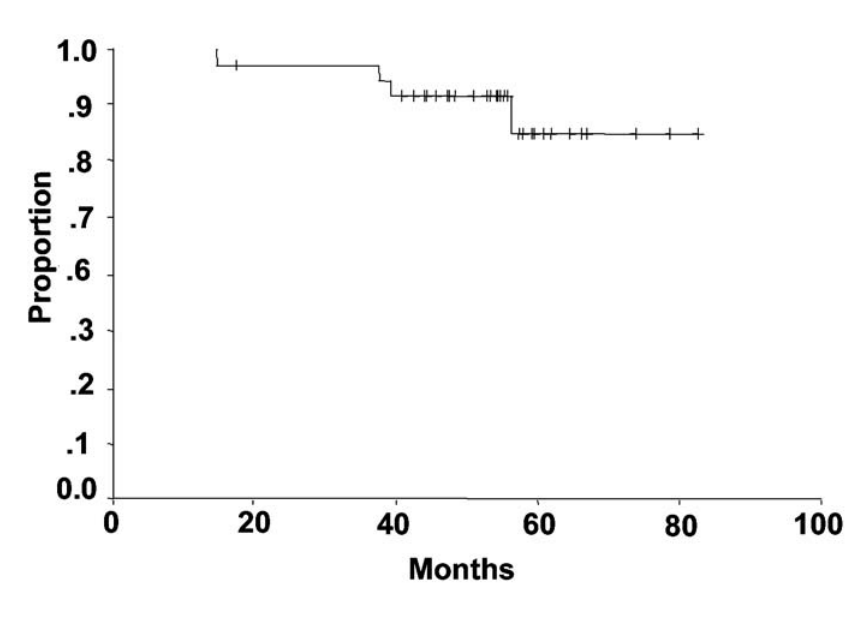
Figure 3 – Actuarial survival rate free from distant metastasis after salvage conformal